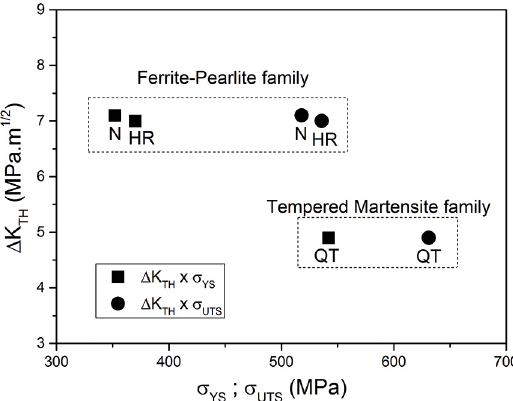
Figure 8. Fatigue threshold and tensile mechanical resistance relationship. HR = hot-rolled; N = normalized; QT = quenched and